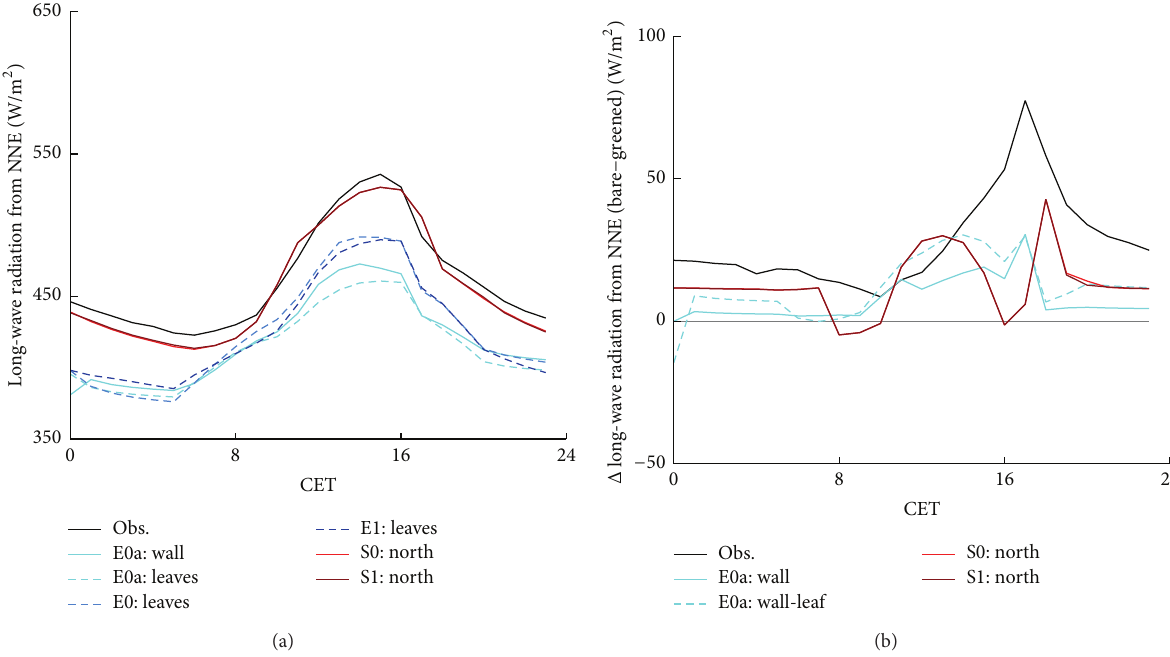
Figure 10: Simulated long-wave radiation (a) emitted from the greened site (wall or leaves) and (b) differences between bare and greened fac¸adein simulations and observation fortheexperiments with ENVI-met 3 (E0a), unforced (E0)and forced ENVI-met 4 (E1),and SOLWEIG without (S0) and with global radiation from observation (S1) (7, 23,